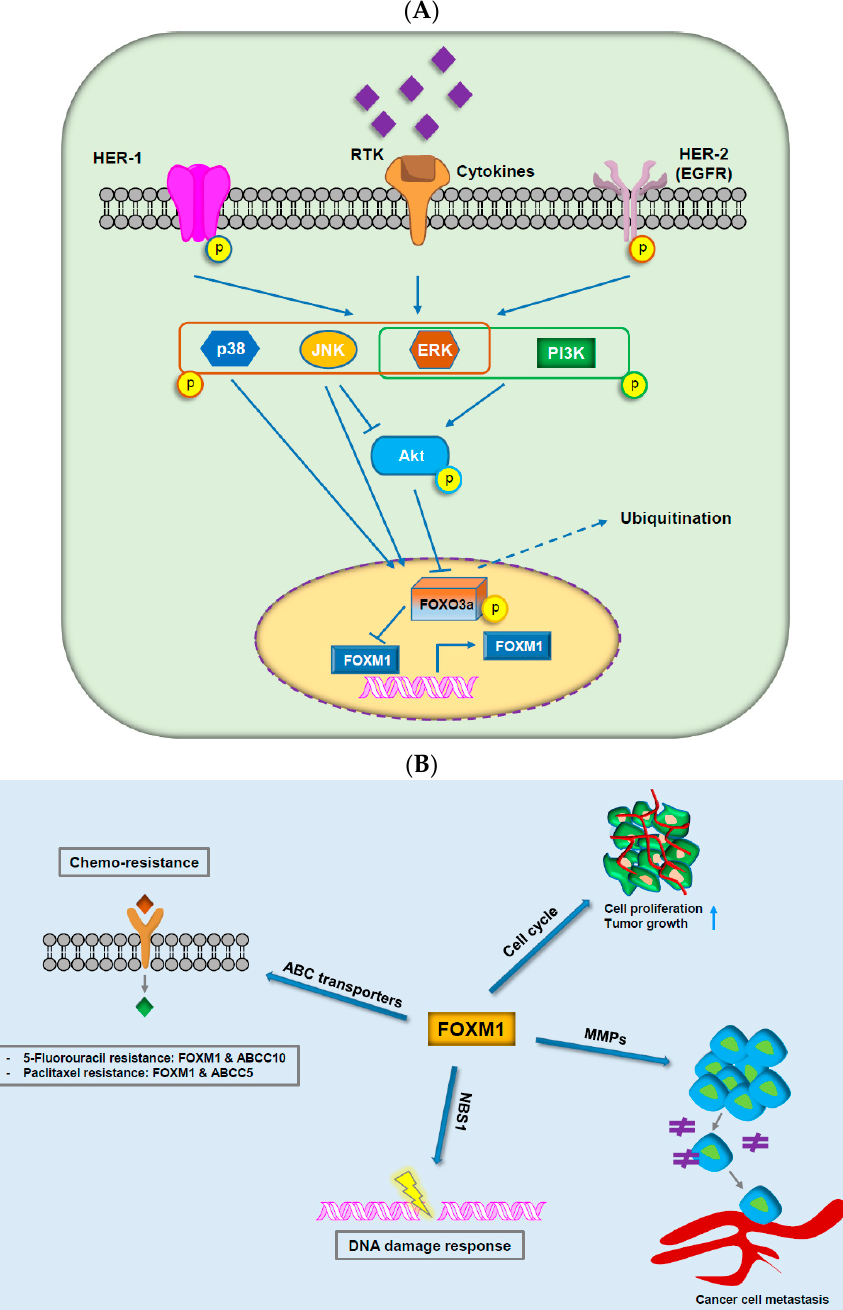
Figure 2. The critical roles of FOXM1 in cancer progression. ( A ) Integration of extracellular and intracellular signaling pathways with the axis of forkhead box protein M1 and forkhead box class O3a. ( B ) FOXM1 contributes to chemo-resistance through ABC transporters, tumor growth and cell proliferation through cell-cycle, cancer cell metastasis through matrix metalloproteinases, and DNA damage response through NBS1.